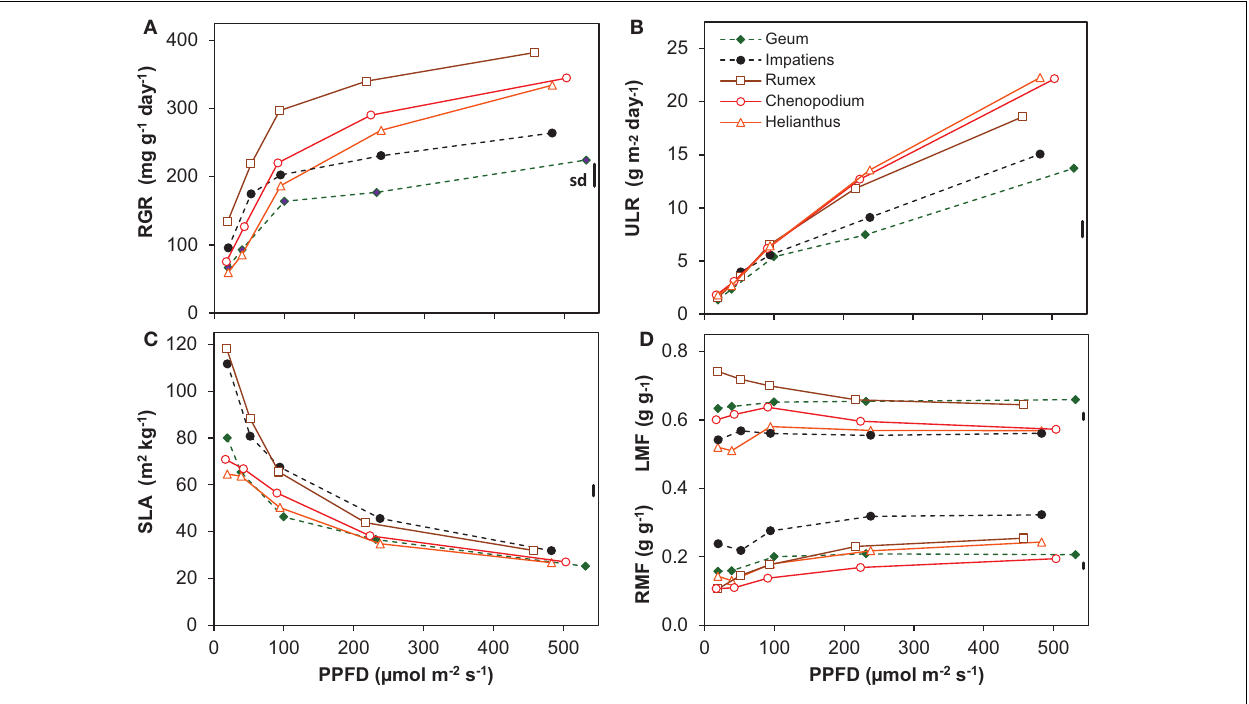
FIGURE 1 | Growth variables of five species grown at five irradiance levels (Photosynthetic photon Flux Density; PPFD). (A) Relative Growth Rate (RGR, dry mass increase per unit plant mass and time); (B) Unit Leaf Rate (ULR, dry mass increase per unit leaf area and time); (C) Specific Leaf Area (SLA, leaf area per unit leaf dry mass); (D) Leaf Mass Fraction (LMF, leaf mass per unit plant mass) and Root Mass Fraction (RMF). Means are shown